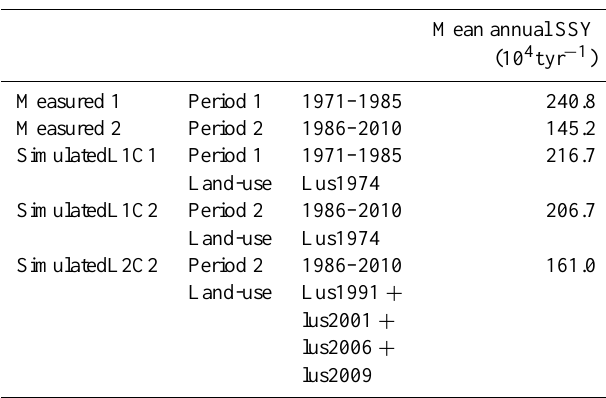
Table 5. Simulated and measured annual suspended sediment yield in the Kejie watershed